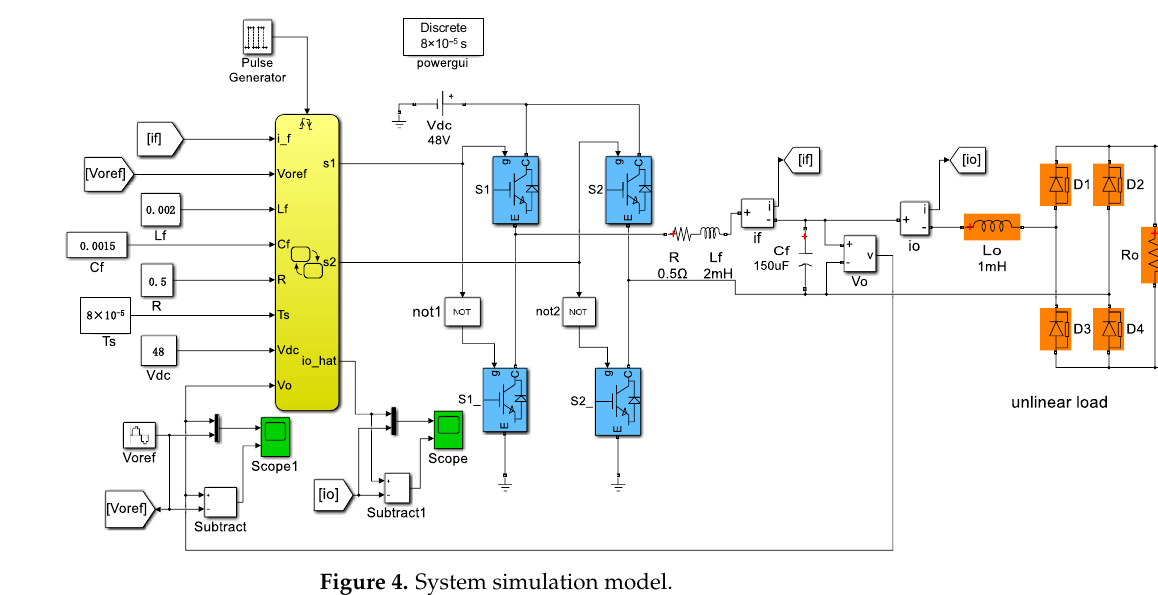
Figure 4. System simulation model.